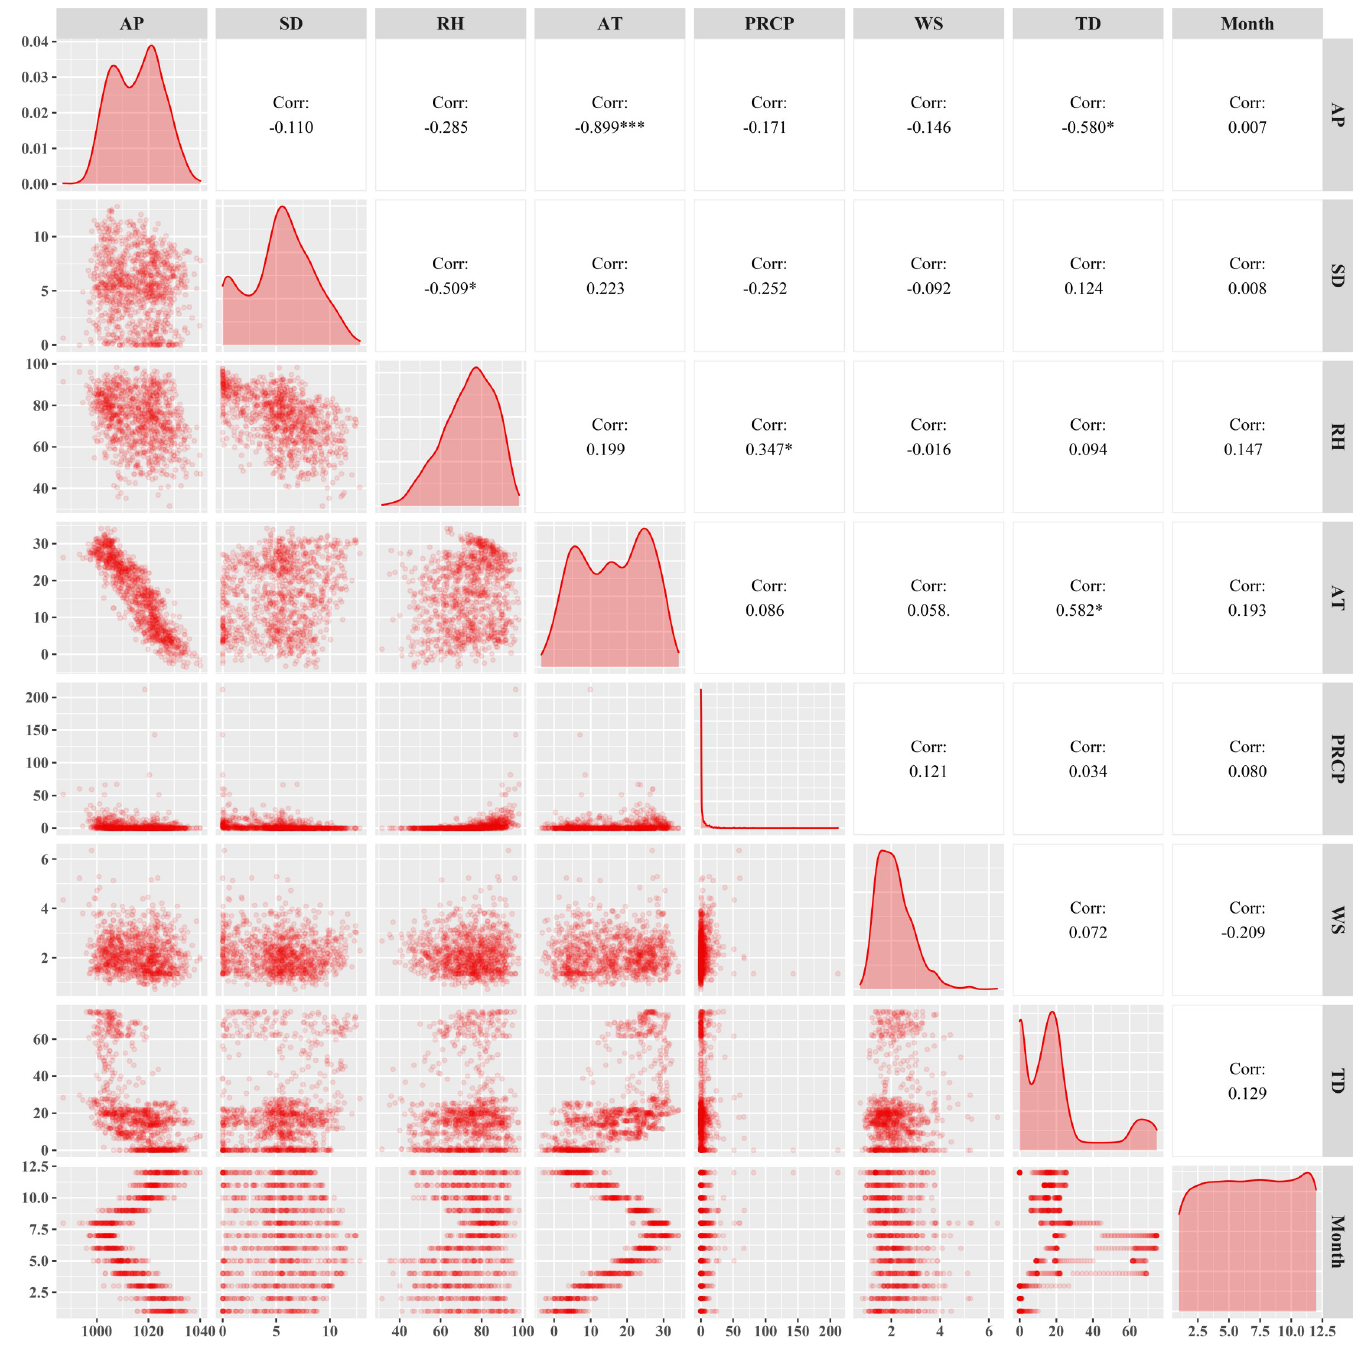
Fig 5. Correlation analysis between time lagging meteorological factors and tick density. AP = Air pressure; SD = Sunshine duration; RH = Relative humidity; AT = Average temperature; PRCP = 24-hour precipitation; WS = Wind speed; TD = Tick density. Correlation coefficient (r) greater than 0.7 indicates a strong correlation between the